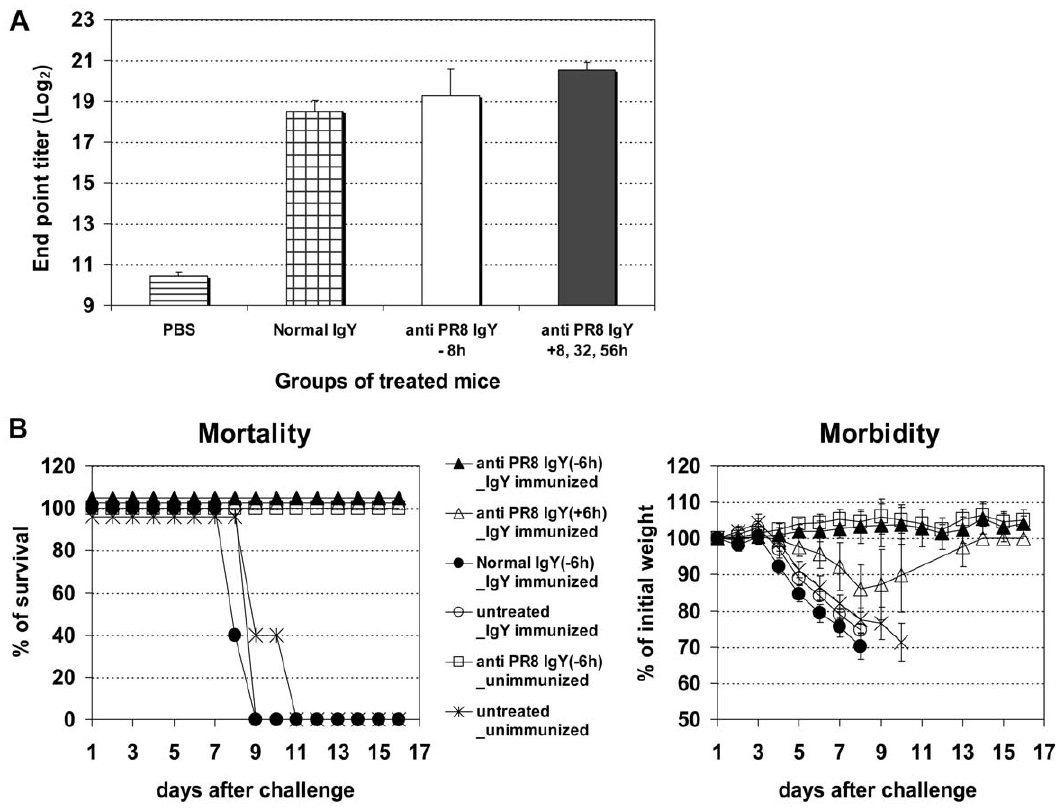
Figure 4. Induction of anti IgY Abs and IgY treatment in mice with pre-existing anti IgY. Anti IgY in the sera of mice immunized with normal IgY (IgY immunized), treated once intranasally with PR8-specific IgY 8 hours before (anti PR8 IgY 2 8 h) or three times after infection (anti PR8 IgY + 8, 32, 56 h) (Fig. 4A). Endpoint titers (log 2 ) were determined by ELISA. Morbidity and mortality of IgY-immunized mice treated with PR8-specific IgY (anti PR8 IgY) before ( 2 6 hr) or after ( + 6 hr) infection with mouse-adapted PR8 (Fig. 4B). The values are the mean of 5–10 mice in each group.